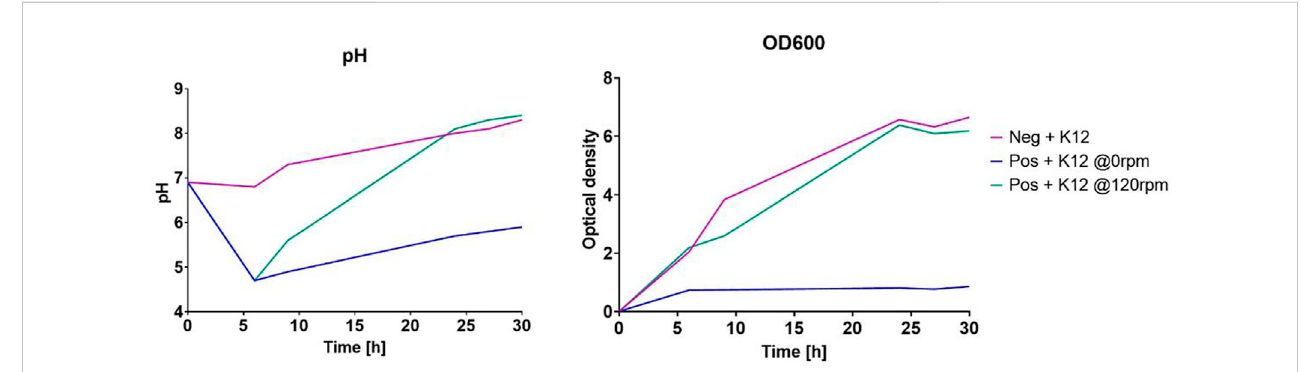
FIGURE 4 Depiction of pH and OD 600 propagation over the course of the second experimental